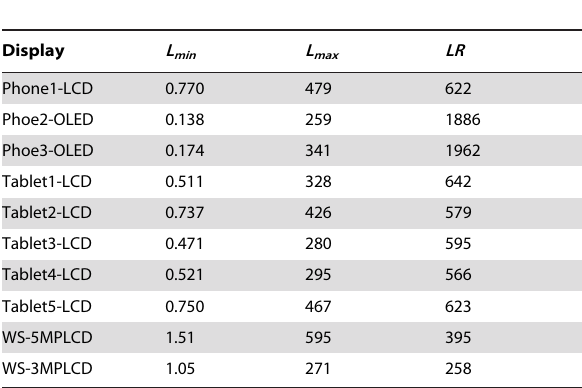
Table 2. Minimum and maximum luminance values and luminance ratios for the devices tested in this